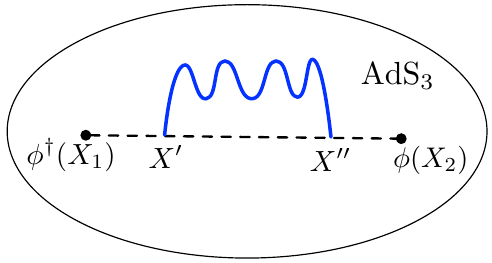
(cid:30) y (cid:30) h i